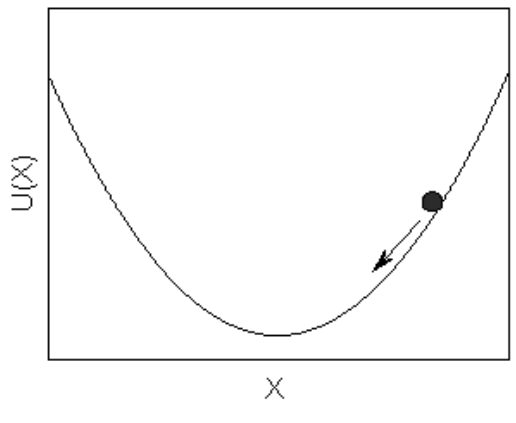
Figure 1. A typical single-well